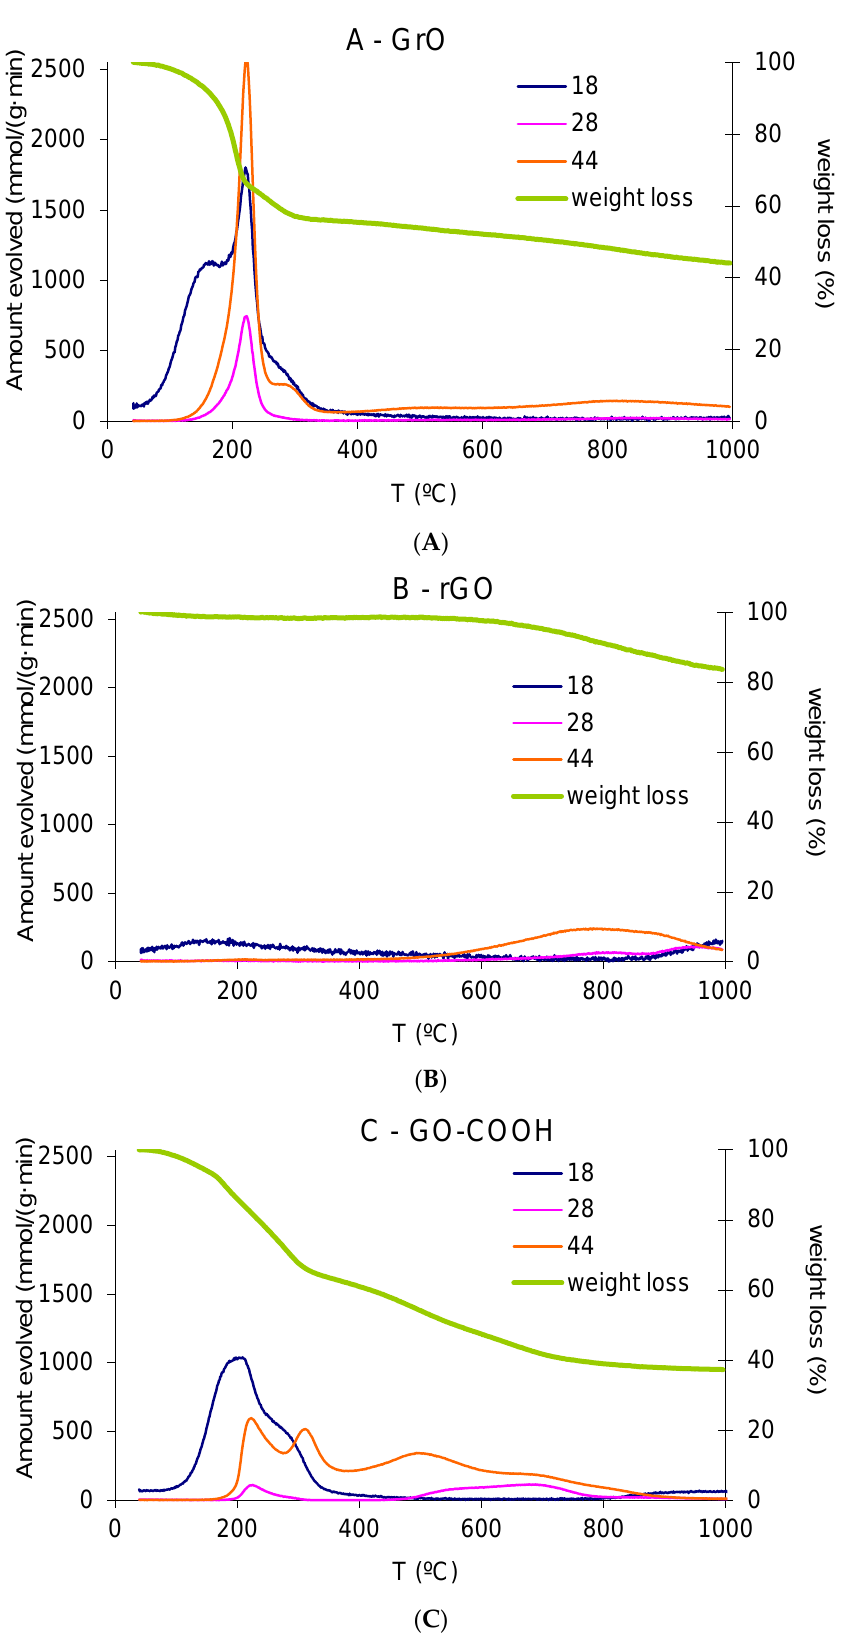
Figure 5. Thermogravimetric weight loss and TGA-MS results for molecular ions of water (18), carbon monoxide (28) and carbon dioxide (44) for ( A ) GrO, ( B ) rGO and ( C ) GO-COOH.